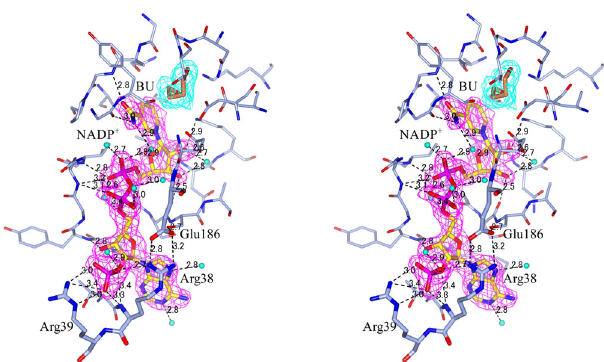
Fig. 7 Stereo-view of a part of the catalytic region. Hydrogen bonds within the substrate-binding pocket of the IM/NADP/BU structure are shown. The 2Fo – Fc electron density in the map is contoured at the + 1.0 sigma